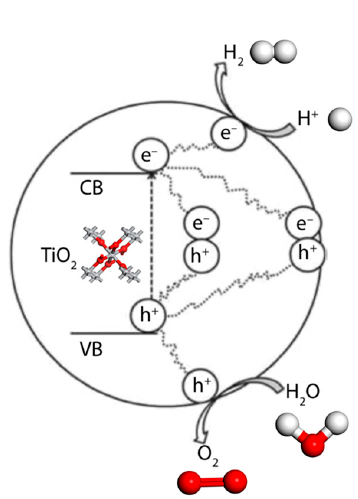
Figure 8. Schematic illustration of three basic processes of photogenerated electrons and holes during photocatalytic water splitting. Reproduced [74] with permission from Scrivener Publishing LLC,